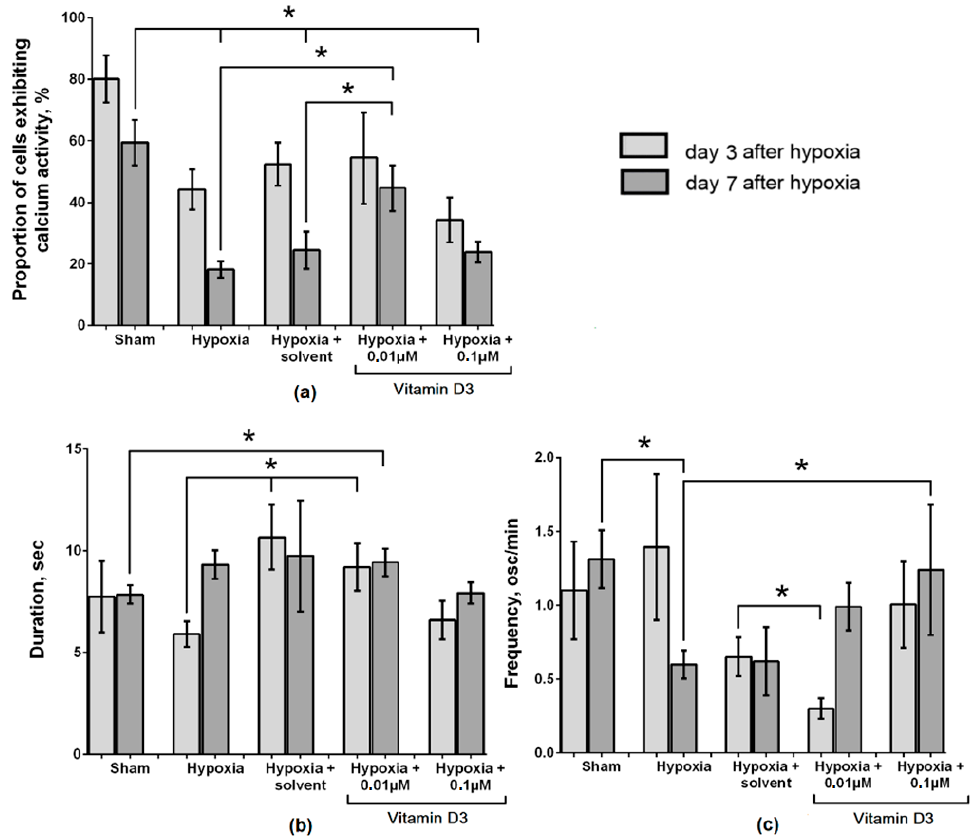
Figure 3. Main parameters of spontaneous calcium activity of primary neuronal cultures in the post-hypoxic period. ( a ) Proportion of cells exhibiting calcium activity; ( b ) Duration of Ca 2+ oscillations, sec; ( c ) Frequency of Ca 2+ oscillations (osc/min). * p < 0.05, one-way ANOVA and Tukey post hoc test.